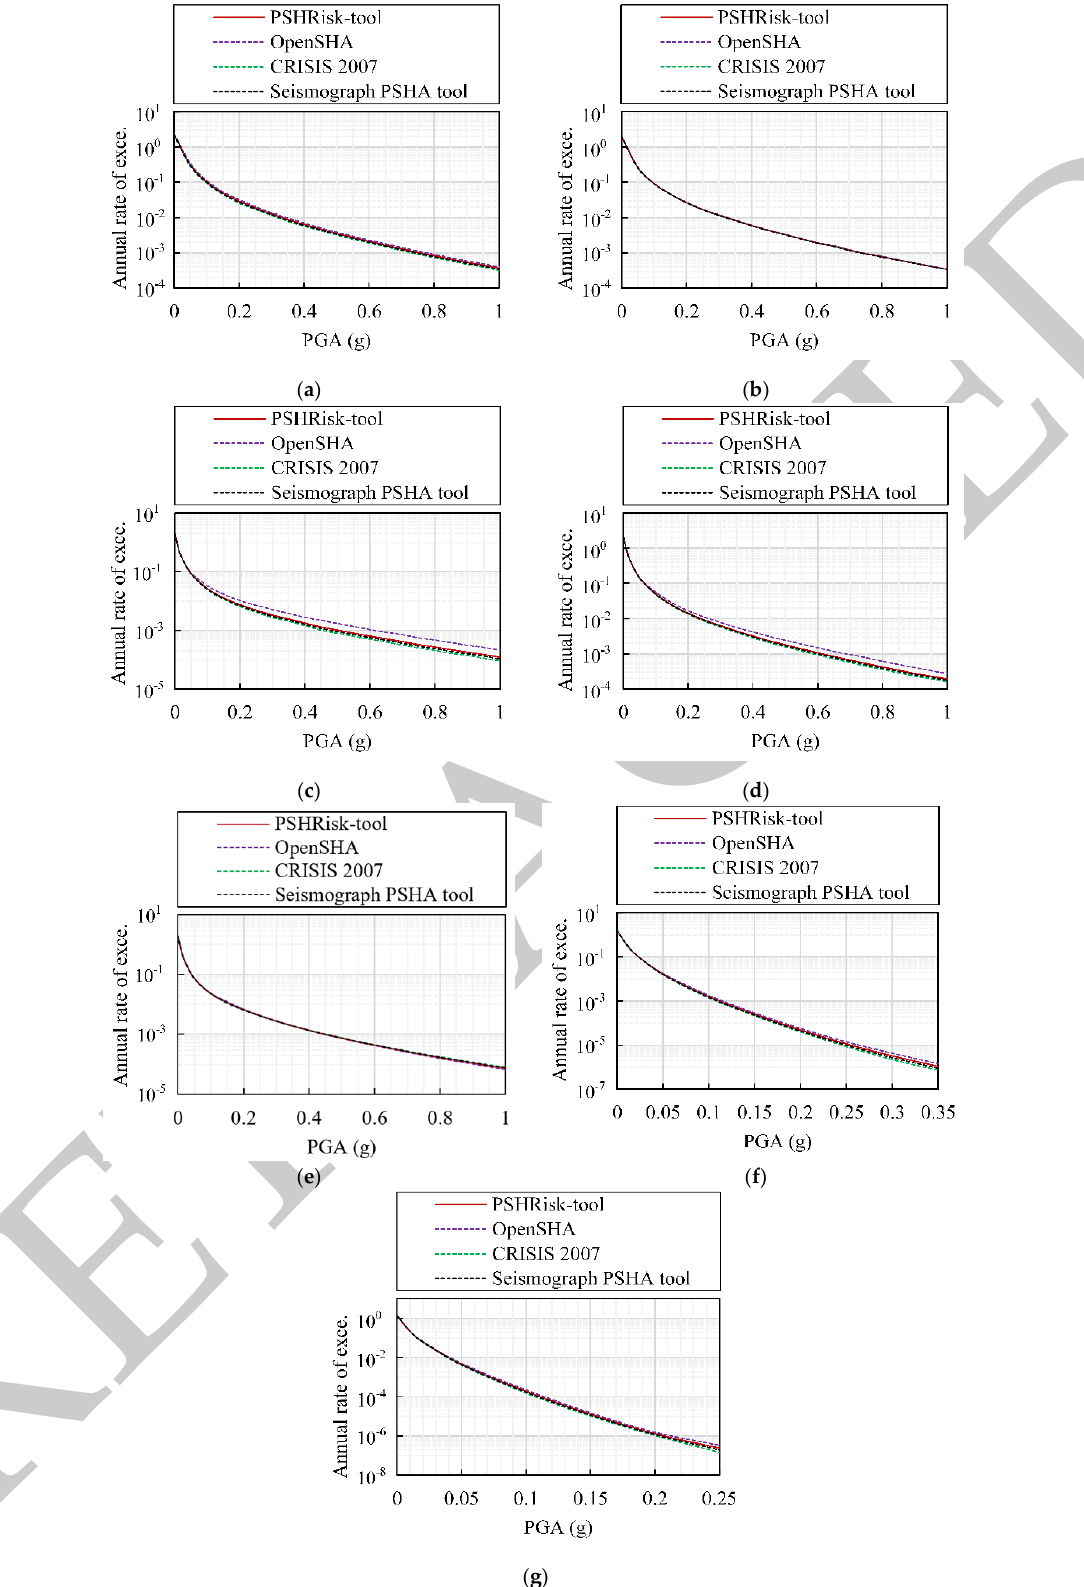
Figure 15. Hazard curves for area source-based test case, ( a ) Site 1, ( b ) Site 2, ( c ) Site 3, ( d ) Site 4, ( e ) Site 5, ( f ) Site 6, ( g ) Site 7.